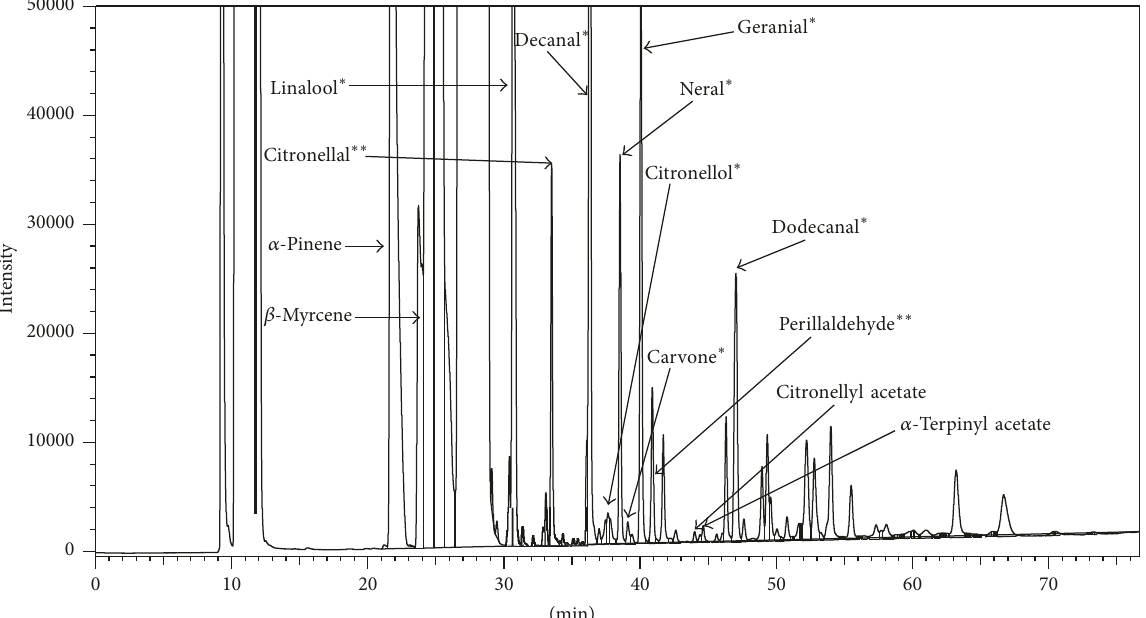
Figure 6: Chromatogram from Valencia Early Symptomatic. Note . While 2-decenal and 2,4-decadienal were quantifiable in this sample, they were not labeled on the chromatogram as the peaks are too small to be seen. ∗ Compound has lower concentration compared to VEA. ∗∗ Compound has higher concentration compared to VEA.